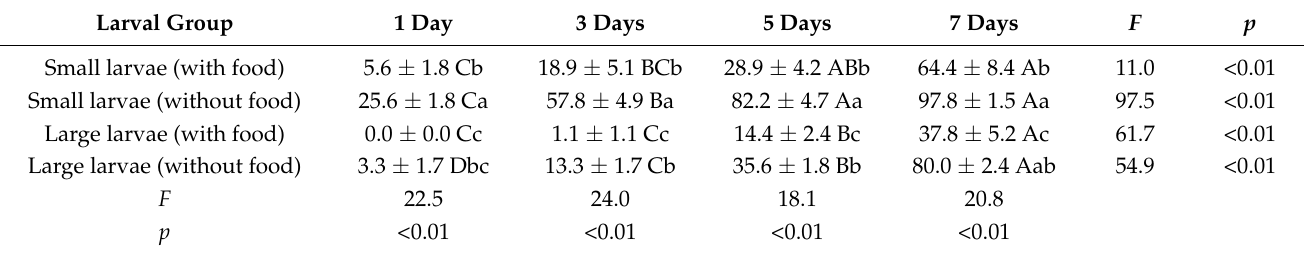
Table 3. Mean short-term mortality (% ± SE) of Alphitobius diaperinus small and large larvae exposed to wheat treated with deltamethrin for 1 day, 3 days, 5 days, and 7 days. Within each row, means followed by the same uppercase letter are not significantly different (in all cases DF = 3, 35, Tukey- Kramer HSD test at p = 0.05). Within each column, means that are followed by the same